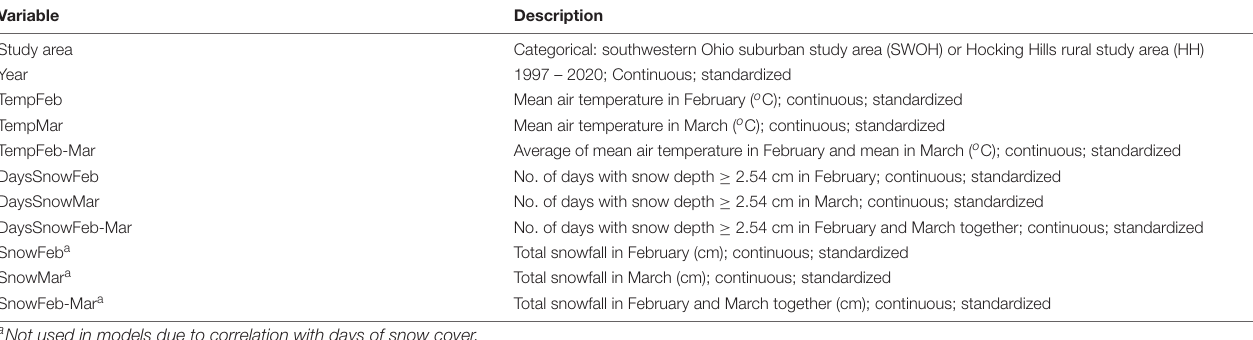
TABLE 1 | Variable abbreviations and descriptions. Variable Description